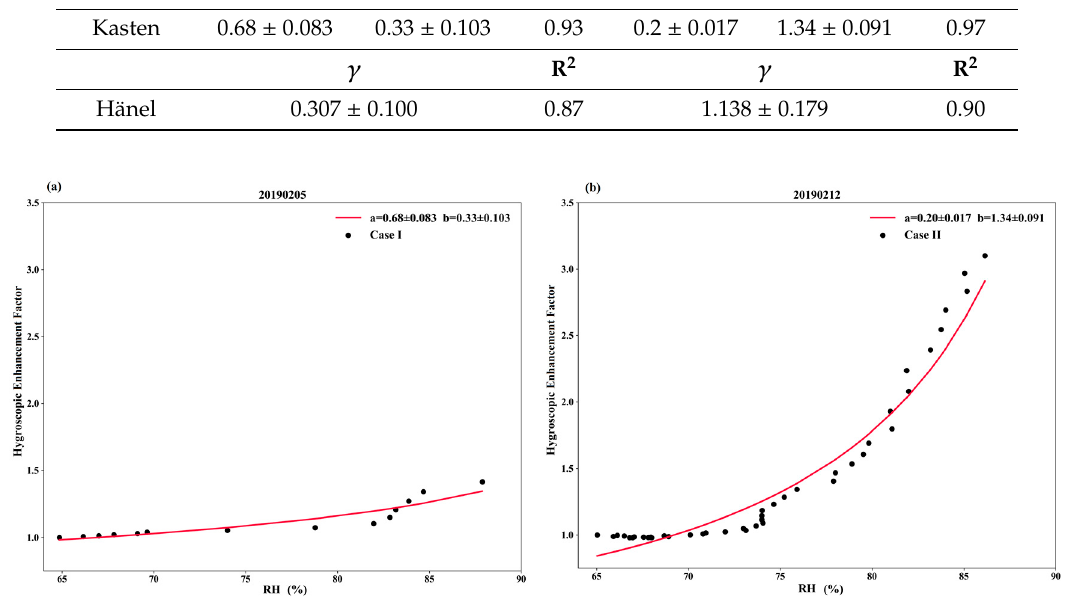
Figure 5. Hygroscopic growth factors ( a ) retrieved on 5 February 2019 (Case I) from 1050 to 1150 UTC between 410 and 540 m (RH ref = 65%), and ( b ) retrieved on 12 February 2019 (Case II) from 1050 to 1150 UTC between 580 and 1000 m (RH ref = 65%). The red line is the result of the fit using the Kasten method based on the data.